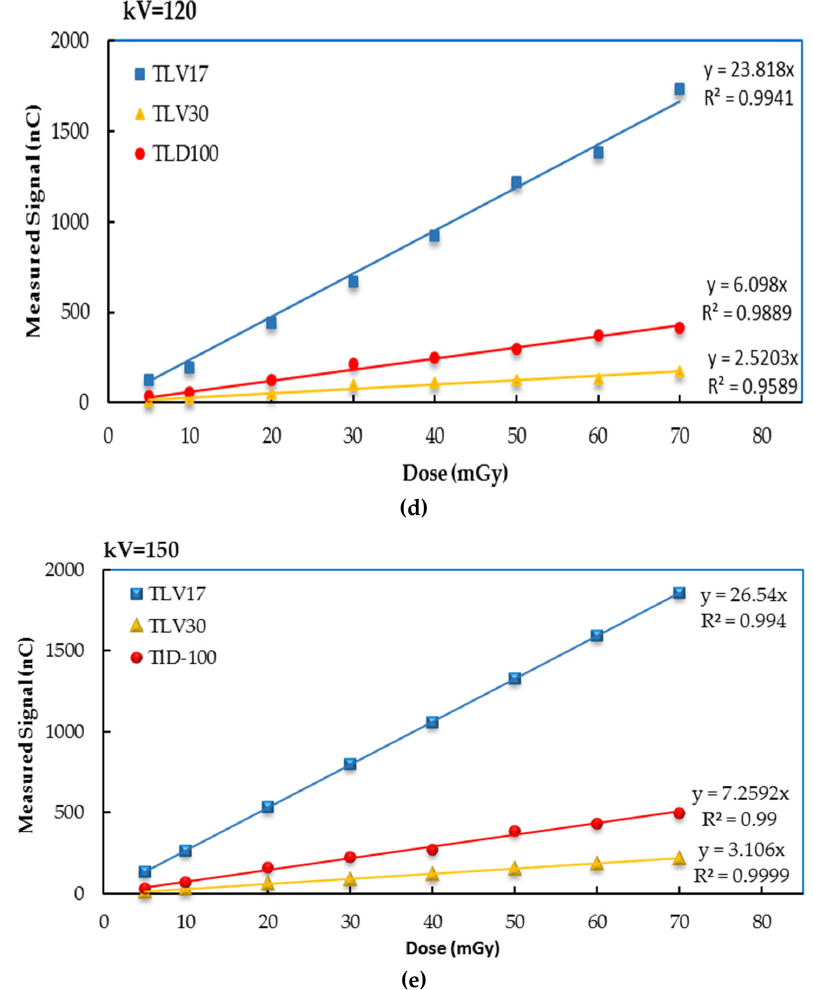
Figure 8. The dose–response linearity for TLV17, TLV30 and TLD-100 from SSDL daignostic X-ray beams. ( a ) KV = 40, ( b ) KV = 80, ( c ) KV = 100, ( d ) KV = 120, ( e ) KV = 150.